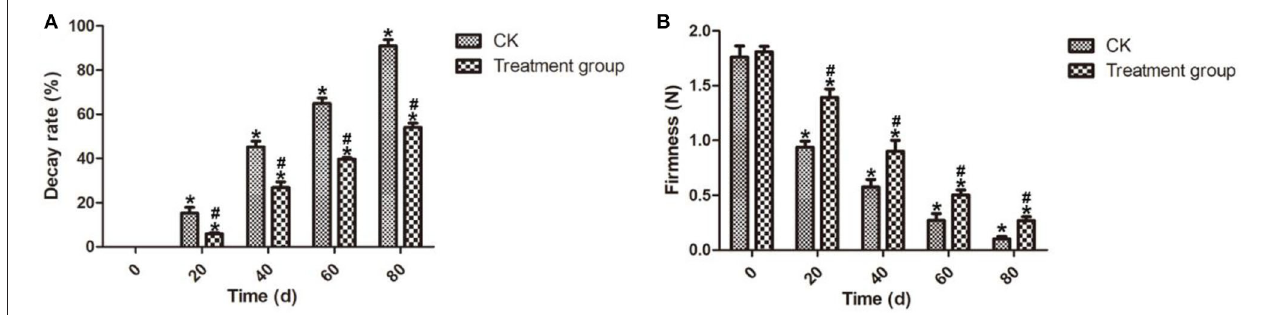
FIGURE 3 | Effects on the decay rates and fruits firmness of the postharvest blueberries after ozone fumigation treatment. (A) Decay rate and (B) Fruits firmness. “*” indicated the decay rates and fruits firmness of ozone fumigation treatment with a significant difference at p < 0.05 compared with the decay rates and fruits